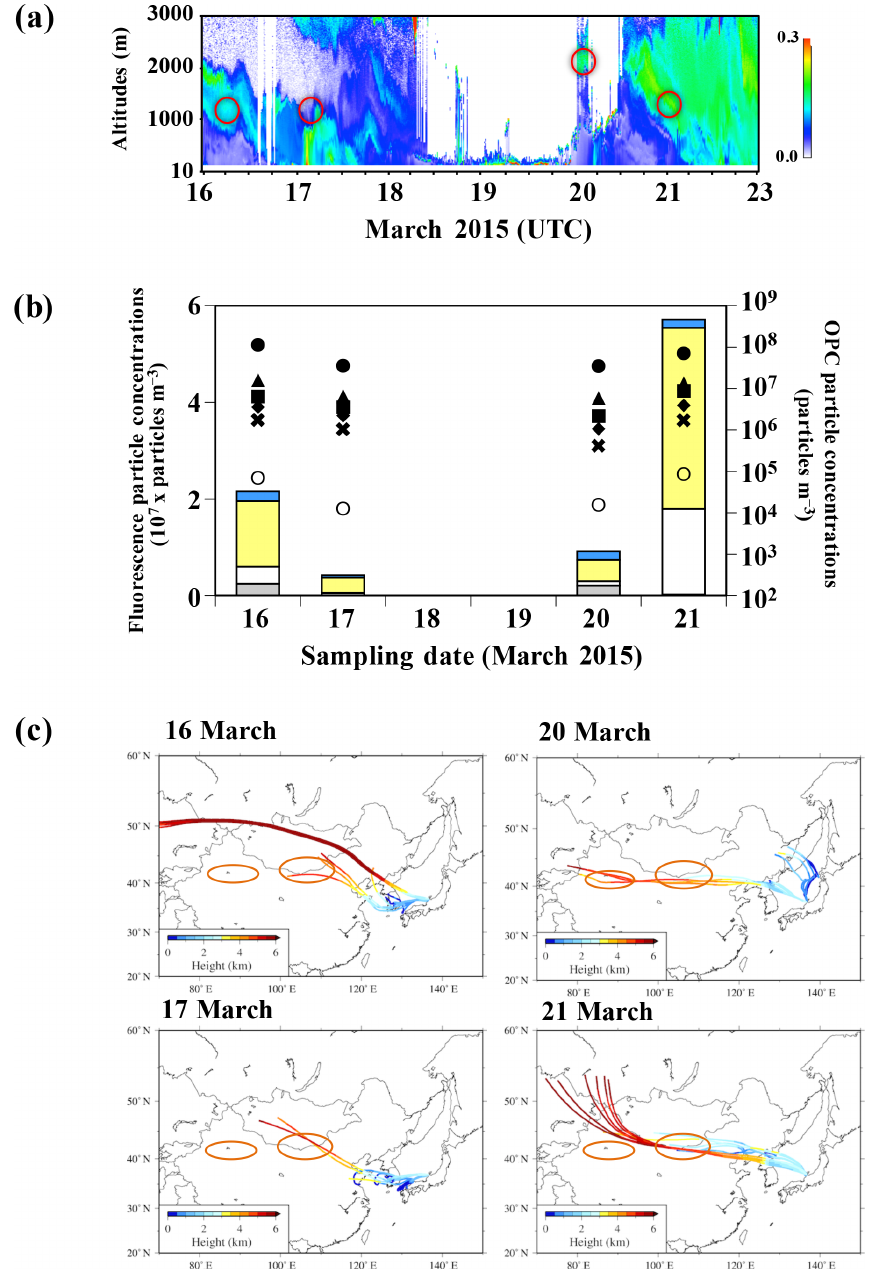
Figure 5. (a) Lidar observation of the depolarization ratio in Toyama city and concentrations of OPC-counted particles and DAPI-stained particles during dust-event days from 00:00UTC on 16 March to 00:00UTC on 23 March 2015. The red circles with solid lines in the lidar images indicate that the sampling air included dust mineral particles. (b) OPC-counted particles were categorized based on diameter sizes of 0.3–0.5µm (closed squares), 0.5–0.7µm (closed triangles), 0.7–1.0µm (closed circles), 1.0–2.0µm (closed diamonds), 2.0–5.0µm (crosses), and > 5.0µm (open circles). DAPI-stained particles were classified into microbial particles (blue bars), white particles (white bars), yellow particles (yellow bars), and black particles (grey bars). (c) Three-day back trajectories of aerosols that arrived at 2500m (blue-type lines) and 1200m (red-type lines) in Hakui, Japan, every hour for 5h before the completion of sampling time during sampling periods on 16, 17, 20, and 21 March